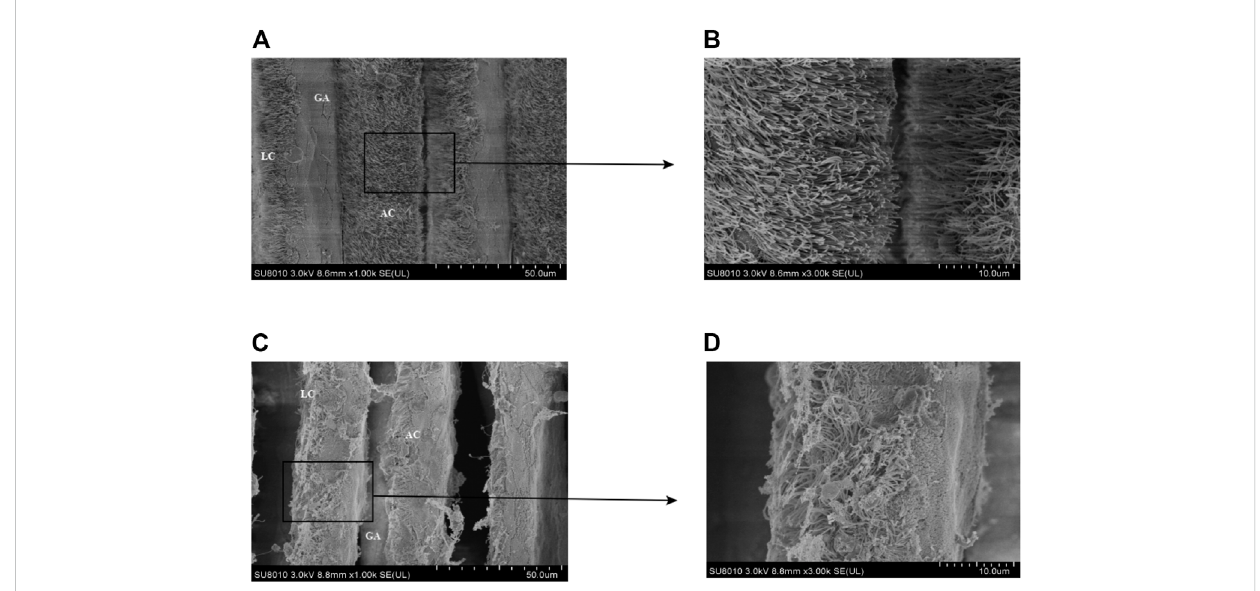
FIGURE 1 SEManalysisof M.coruscus. (A) controlgroup; (B) blackenlargedareainFigure (A) ; (C) starvationgroup; (D) blackenlargedareainFigure (C) ;GA,gill axis; LC, lateral cilia; AC, terminal cilia.